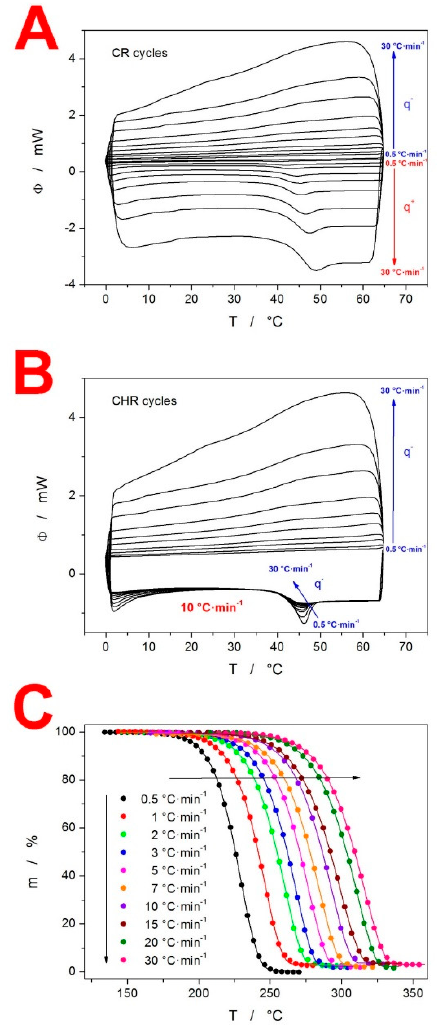
Figure 2. ( A ) Full DSC record of the set of CR cyclic relaxation measurements obtained for the amorphous IMC. The arrows and symbols q − and q + denote the parts of the DSC data in which the cooling and heating steps (respectively) of the CR cycles are shown. Absolute magnitudes of q − and q + applied in the corresponding steps of the cyclic program increase in the directions of the given arrows. ( B ) Full DSC record of the set of CHR cyclic relaxation measurements obtained for the amorphous IMC. In the CHR measurements, q − varied, and q + was always 10 ◦ C · min − 1 . The arrow and symbol q − denote the parts of the DSC data which differ in accordance with applied q − . In the upper part of the graph (where the cooling steps are depicted), the absolute magnitude of q − in- creases with the arrow. In the part where the heating steps are shown, the arrow denotes the in- crease in |q − | in the preceding cooling step. ( C ) Full set of TGA curves obtained for the bulk IMC.